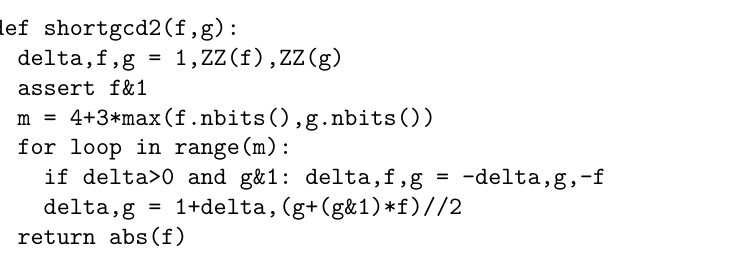
Figure 1.2: Example of a gcd algorithm for integers using this paper’s division